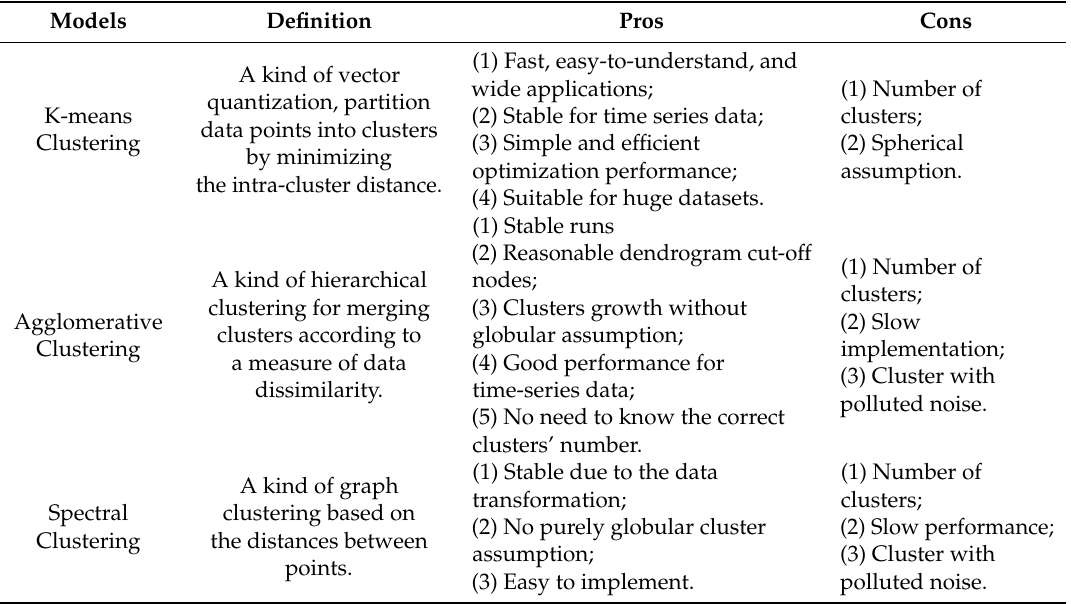
Table 1. Clustering algorithm information